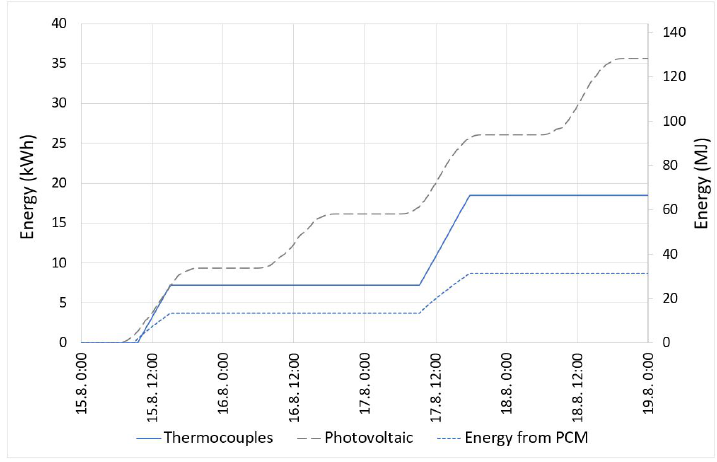
Figure 11. Balance of the energy consumption and production.